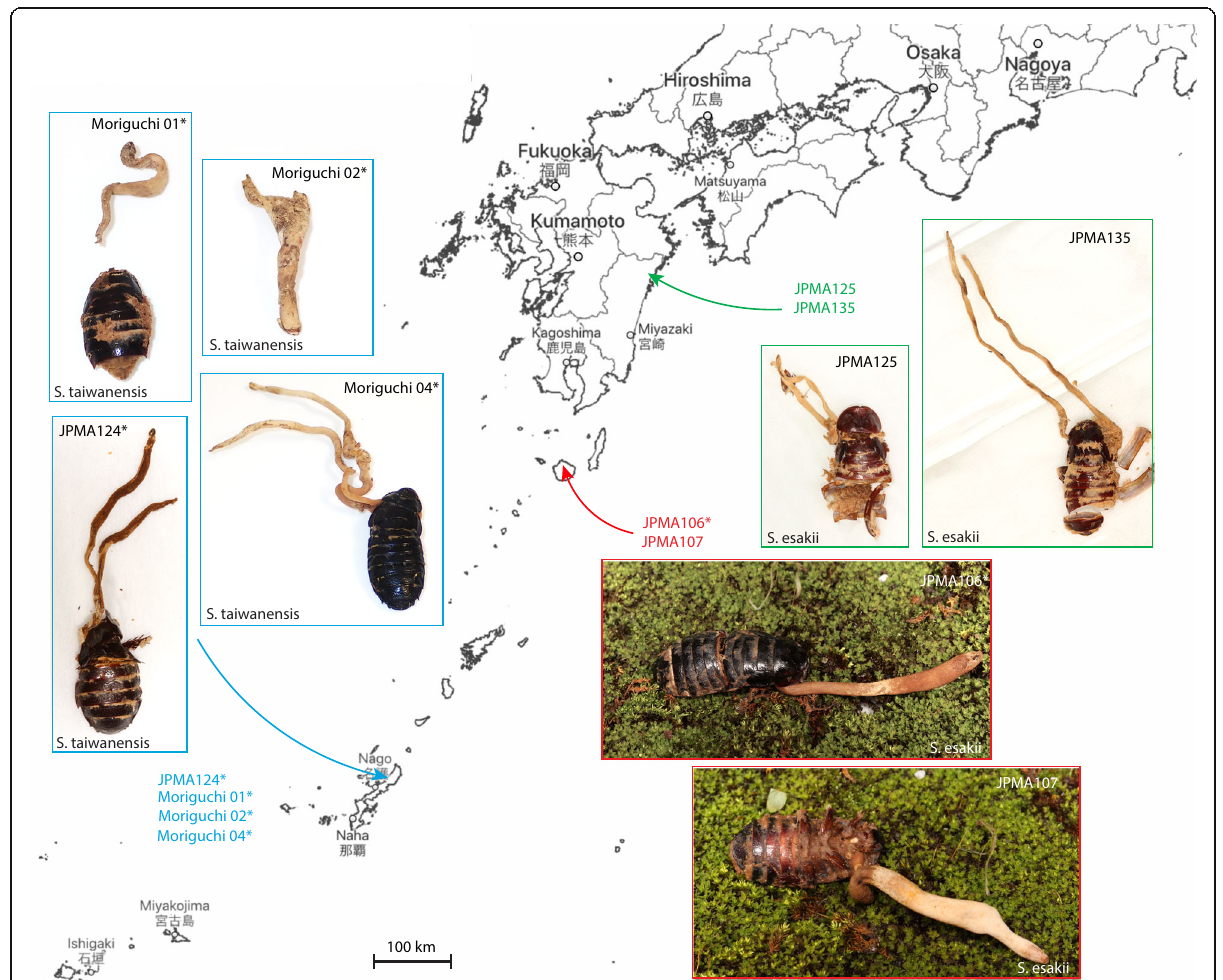
Fig. 3 Southwestern part of Japan showing collection sites of O. salganeicola specimens used in this study. Specimen details are indicated in Table 1. The map was retrieved and edited from Geospatial Information Authority of